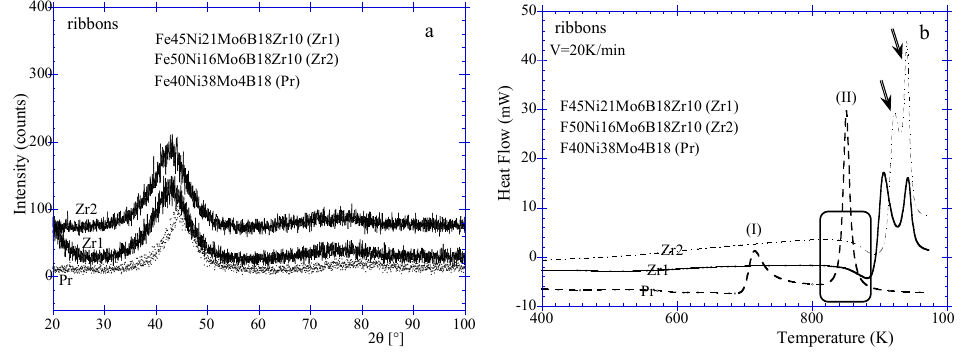
Figure 4. ( a ) XRD patterns of Fe Ni Mo B (Pr) ribbons. ( b ) DSC curves of Fe Fe 40 38 4 18 and Fe Ni Mo B ribbons. 40 38 4 18